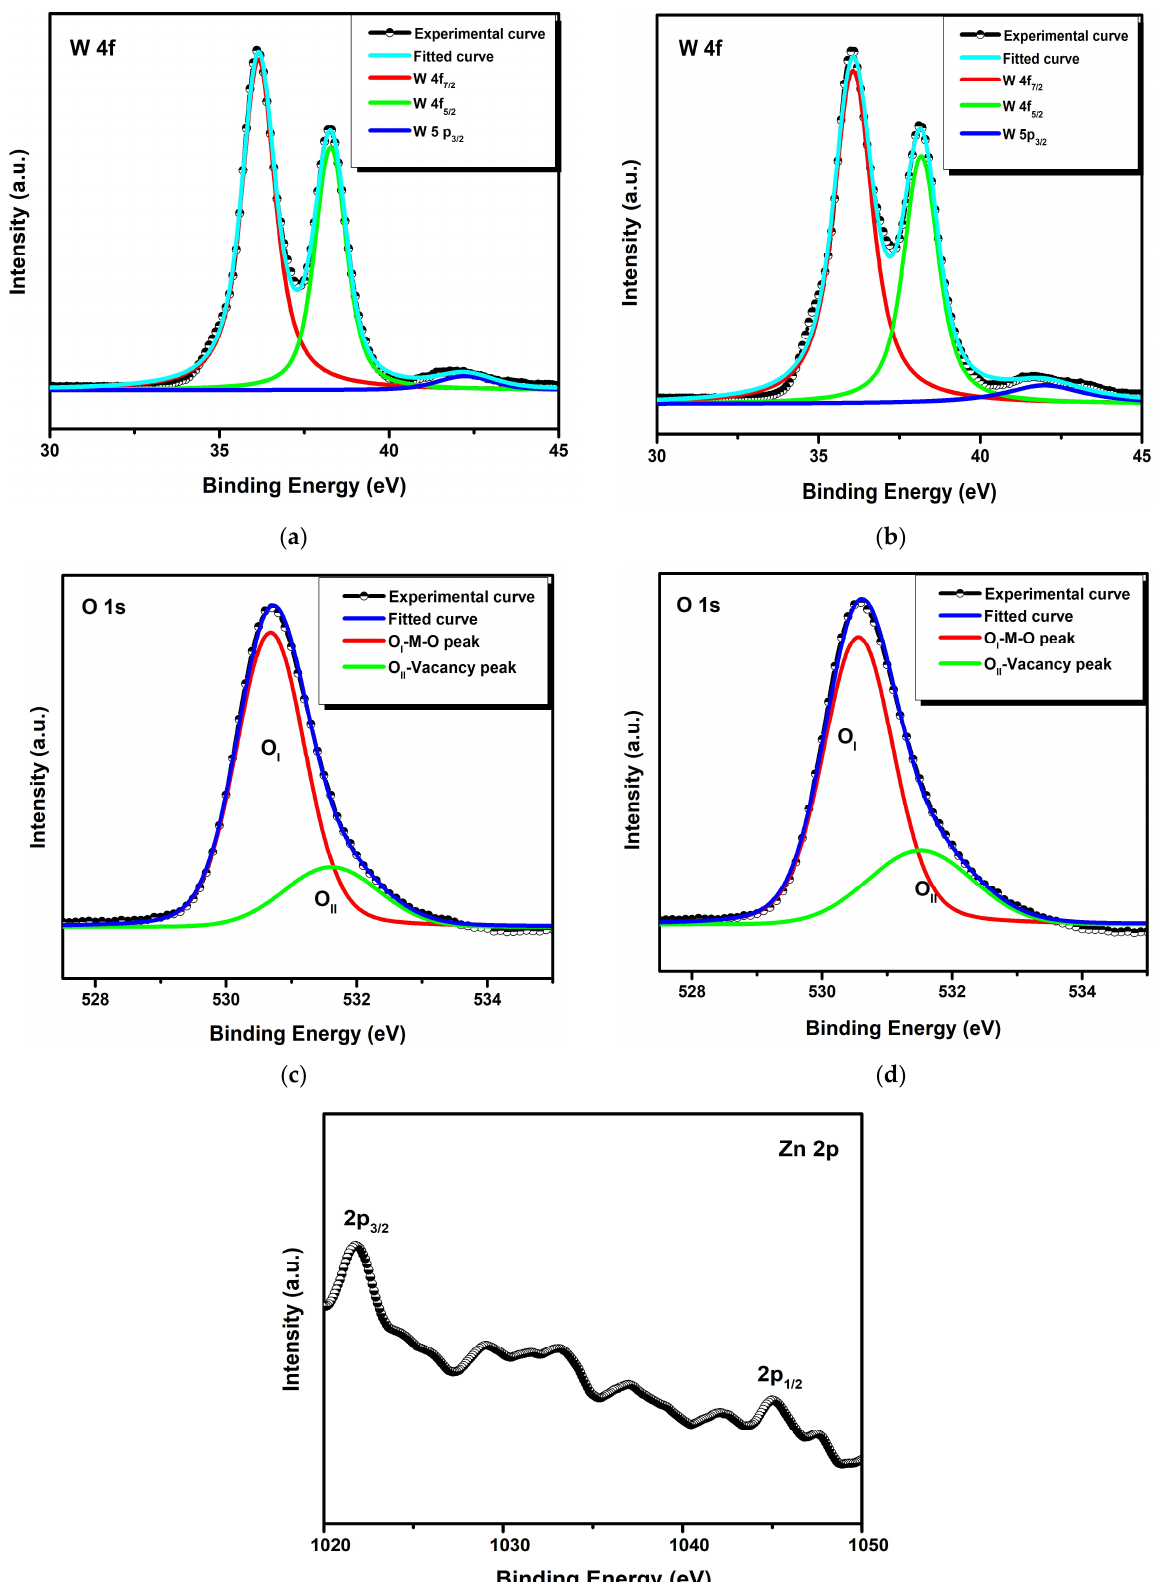
Figure 5. Deconvoluted core level XPS spectra of ( a , b ) W 4f ( c , d ) O 1s ( e ) Zn 2p in WO 3 and Zn: WO 3 ,